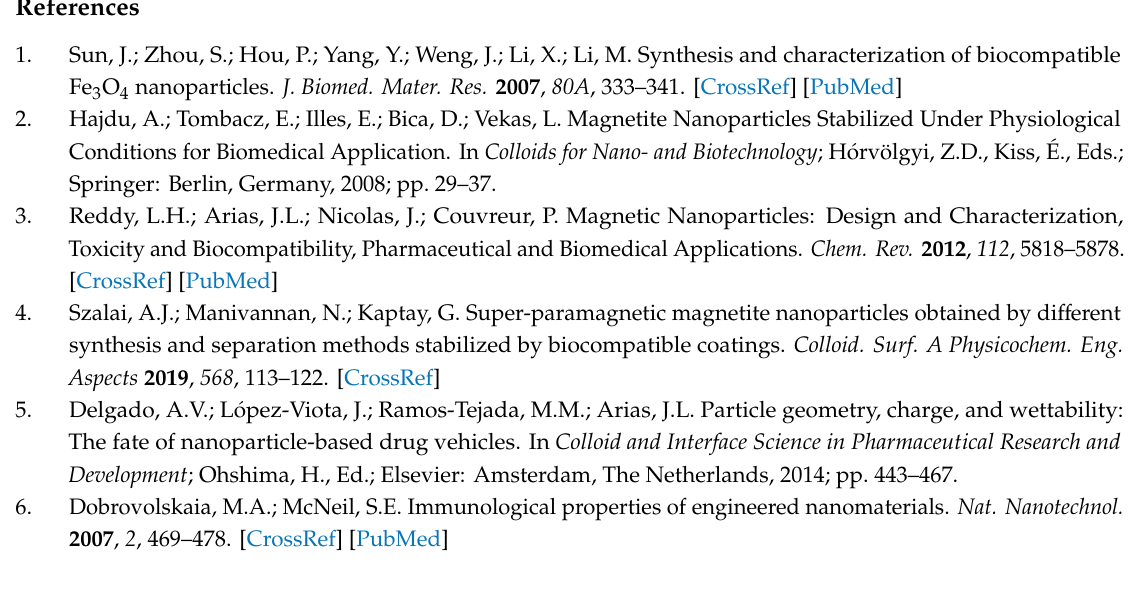
Figure S3: Stability test: time evolution of the electrophoretic mobility measurements of polymer-coated MNRs, Figure S4: X-ray di ff raction patterns of precursor hematite nanorods, and their magnetic products (magnetite and maghemite), Figure S5: ATR-FTIR spectra of bare and coated H2M and J3M MNRs, and of the individuall coating polymers, Table S1: Synthesis conditions of the hydrothermal process and mean particle length, Table S2: Synthesis conditions of the co-precipitation method and mean particle length of precursor